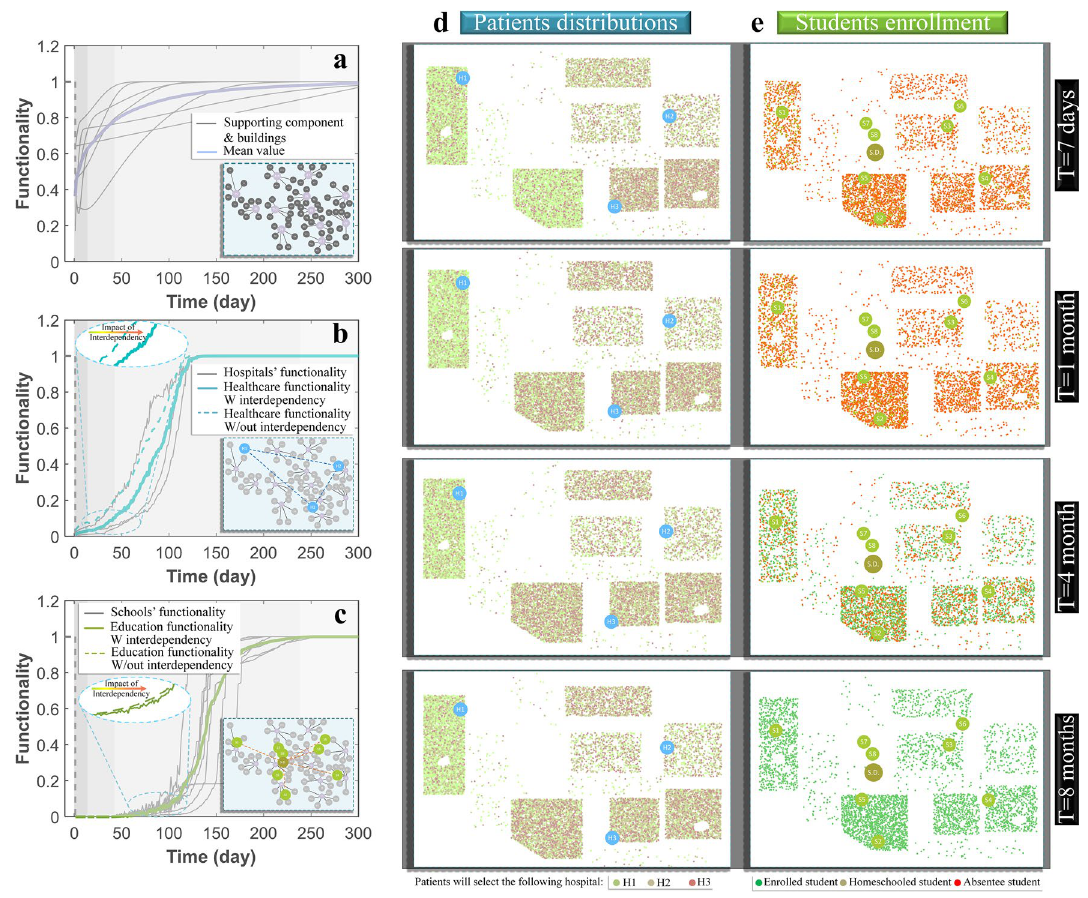
Figure 3. The functionality of ( a ) supporting infrastructure, ( b ) healthcare system, and ( c ) education system, in addition to the change of ( d ) patient distributions, and ( e ) student enrollment status after the earthquake